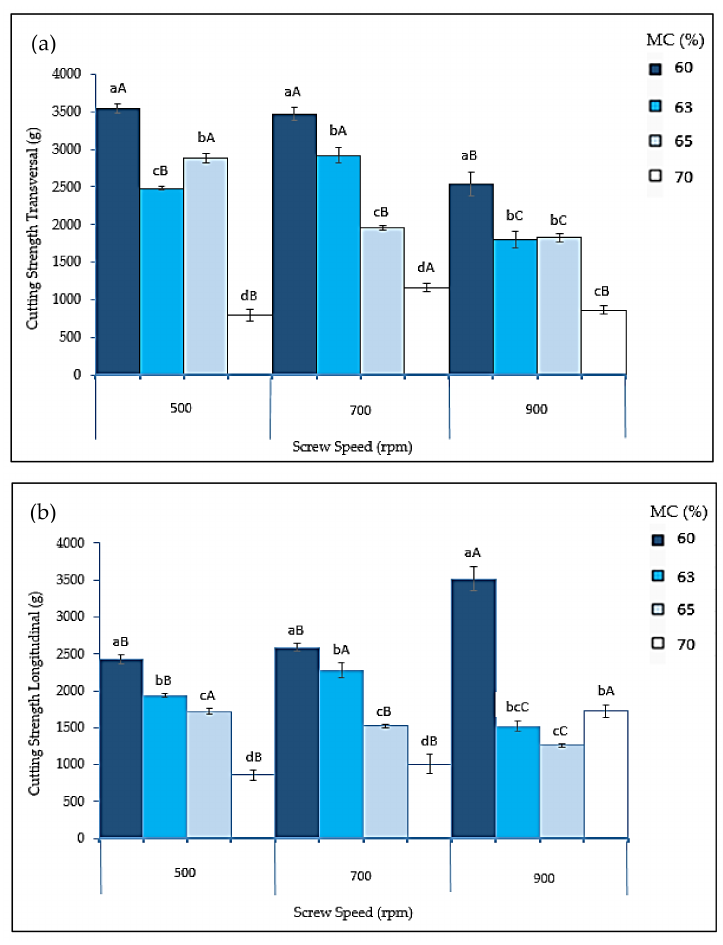
Figure 5. ( a ) Transversal cutting strength; ( b ) longitudinal cutting strength of different extrudates formulations at each target moisture content. Bars represent the mean ± standard deviation. Different lowercase letters indicate a significant difference between different target moisture contents at the same screw speed, and different uppercase letters indicate a significant difference between different screw speeds at the same target moisture content (Tukey’s test, p < 0.05). MC = moisture